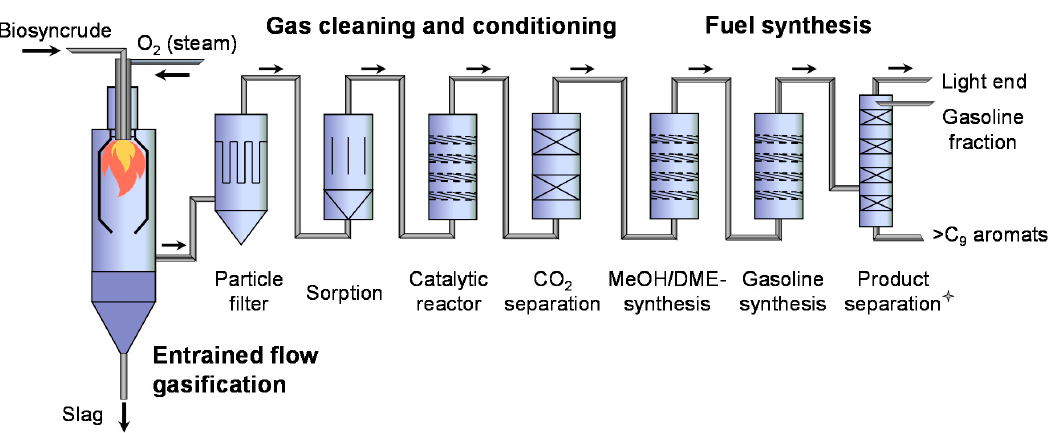
Figure 1. Schematic of the de-centralized fast pyrolysis process.